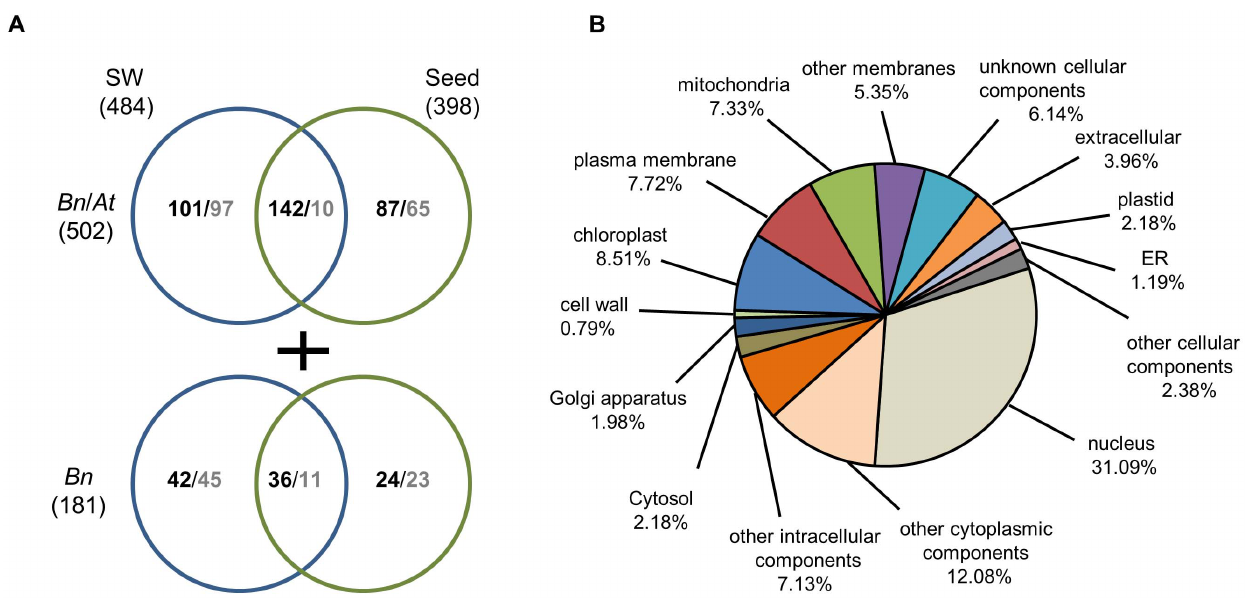
Figure 6. Differentially expressed genes with unknown functions in the heat-stressed SW and seed organs. (A) Venn diagram indicating the numbers of unknown genes conserved and not conserved with Arabidopsis that were detected in the SW or seeds. (B) Cellular components of 502 genes with unknown functions that were conserved with Arabidopsis based on GO analysis in TAIR (http://www.arabidopsis.org/).